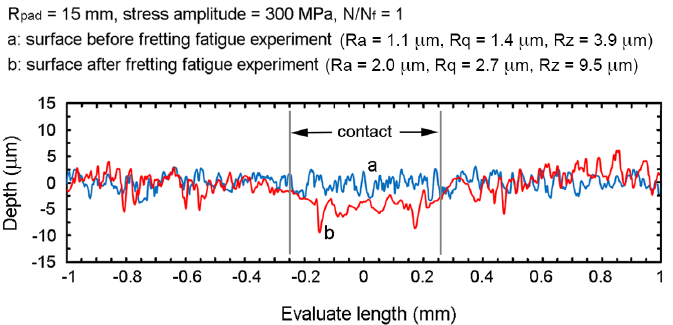
Figure 8. Surface roughness of specimen before and after fretting fatigue experiment ( R pad = 15 mm and stress amplitude of 300 MPa).